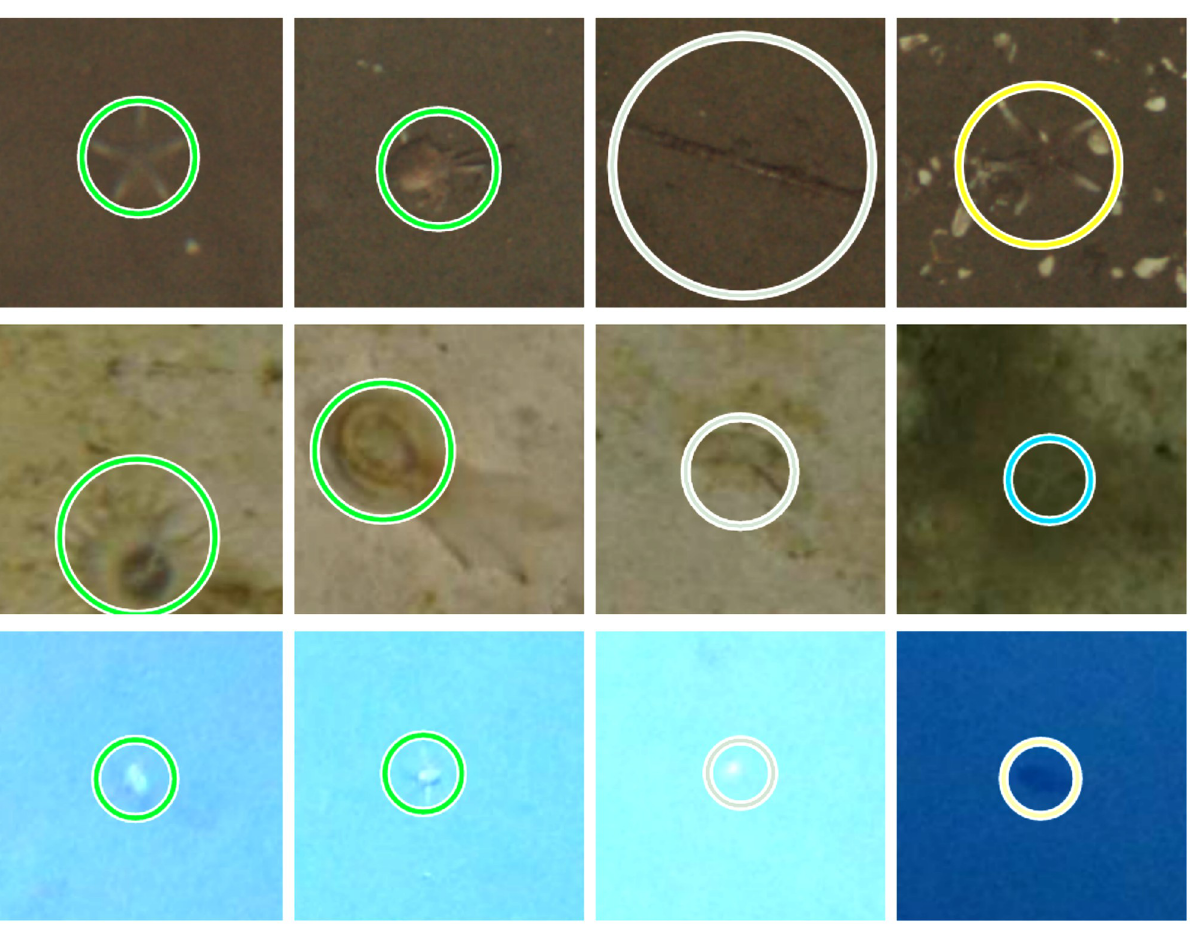
Fig 7. Example annotation candidates (column 1-2 true positives, column 3 false positives) from A JC77 (bottom row). Column 4 shows false negatives from the respective validation subset V Γ .